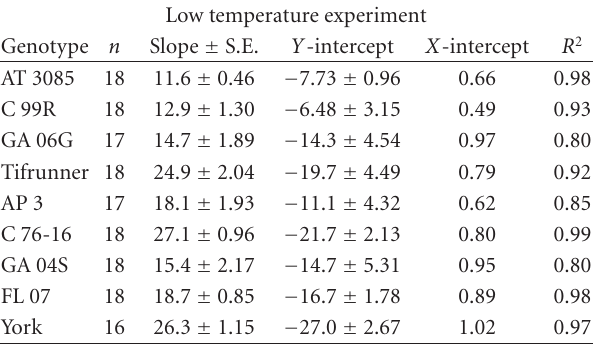
Table 3: Linear regression analysis of response to vapor pressure deficit based on the results from the Low Temperature experiment. The number of data for each cultivar is listed in the column labeled n and the data are followed by the standard error of the mean. Low temperature experiment